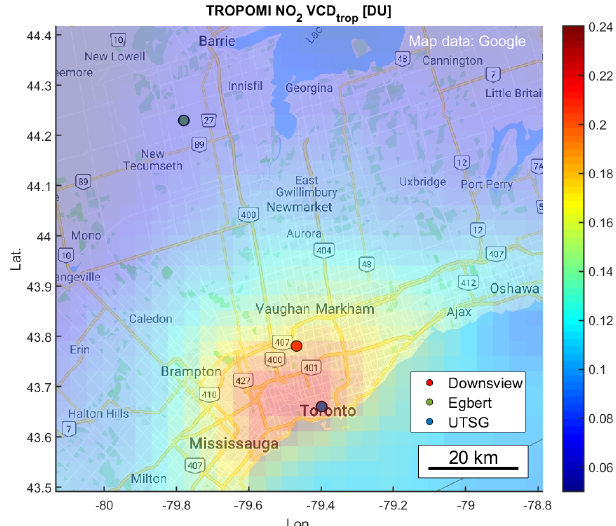
Figure 1. Pandora sites in and north of the Greater Toronto Area. Colour dots indicate the sites. The map (© Google Maps) is masked with TROPOMI KNMI NO 2 tropospheric columns smoothed by pixel averaging (March 2018 to March 2019).